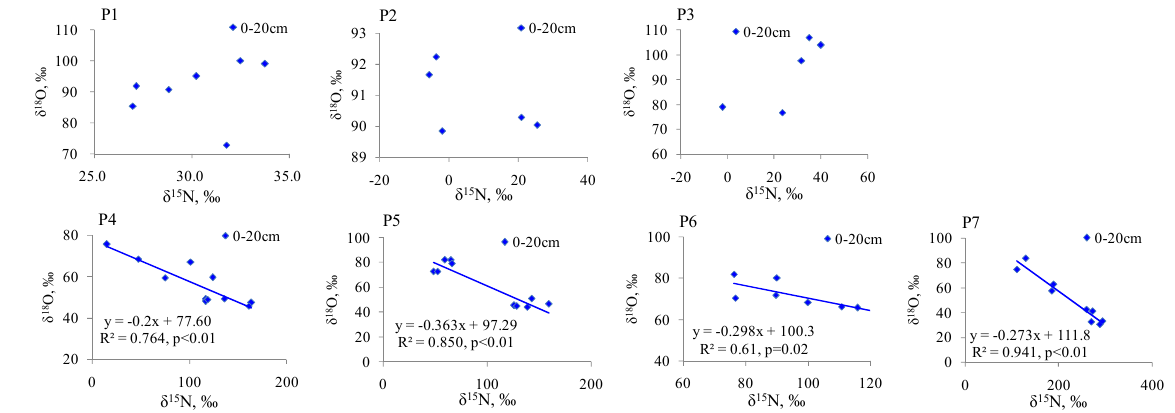
Figure 4. Relationships between δ 18 O and δ 15 N of NO − in the topmost 20cm of the snowpits. Least squares regressions are noted with Fig. 4. Relationships between δ 18 O and δ 15 N of NO 3- in the topmost 20 cm of the snowpits. Least squares 3 lines and are significant at p regressions are noted with lines and are significant at p <0.05.